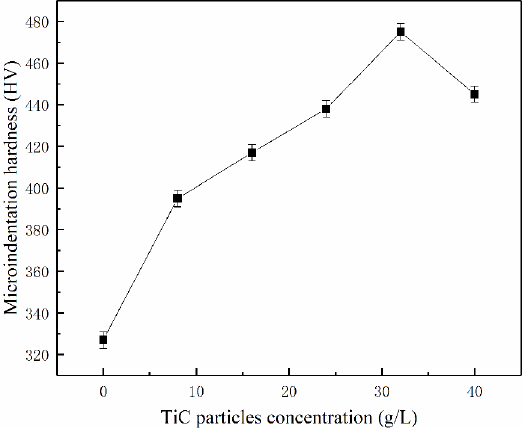
Figure 9. Effects of TiC particles concentration on micro-indentation hardness of Ni-TiC composite coatings